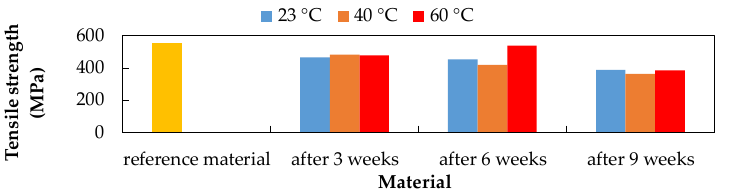
Figure 5. Influence of exposure to 10% NaOH at different temperatures on the CFRP composite. Due to the influence of the CFRP composite exposure to 15% H 2 SO 4 (Figure 6), the largest decrease in tensile strength was recorded after nine weeks of exposure and the smallest decrease in tensile strength after six weeks at 60 °C.